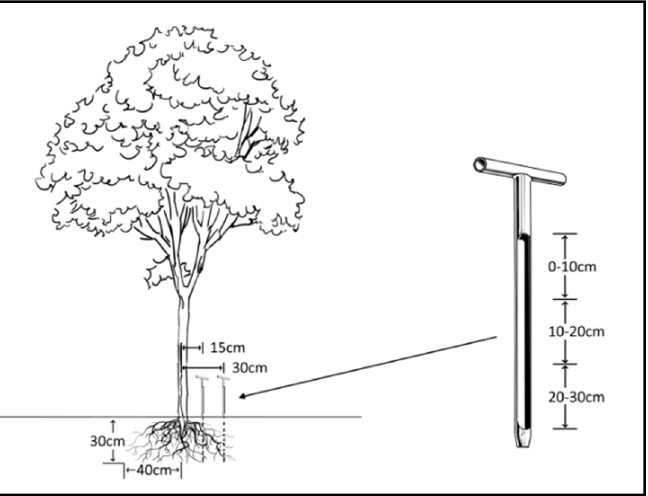
Figure 2. Fine roots were analyzed in different vertical and horizontal levels by coring at distances of 15 and 30 cm from the trunk.